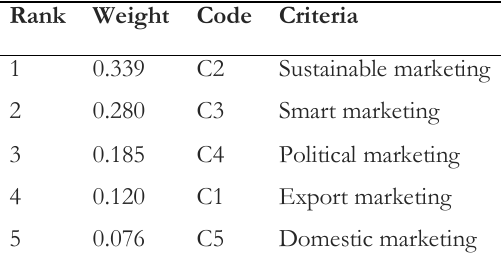
Table 3. Weight and rank of the main criteria.